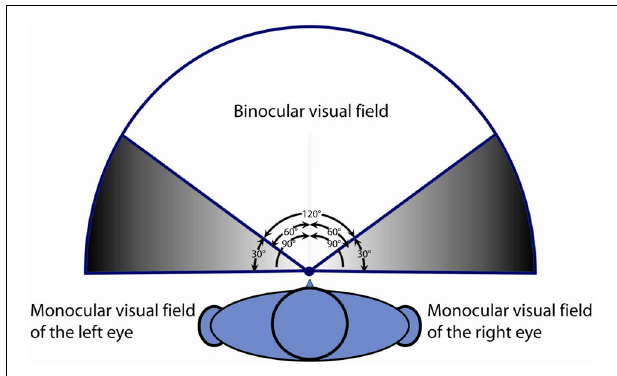
step width ( Figure 6A ), moving toward more positive values;